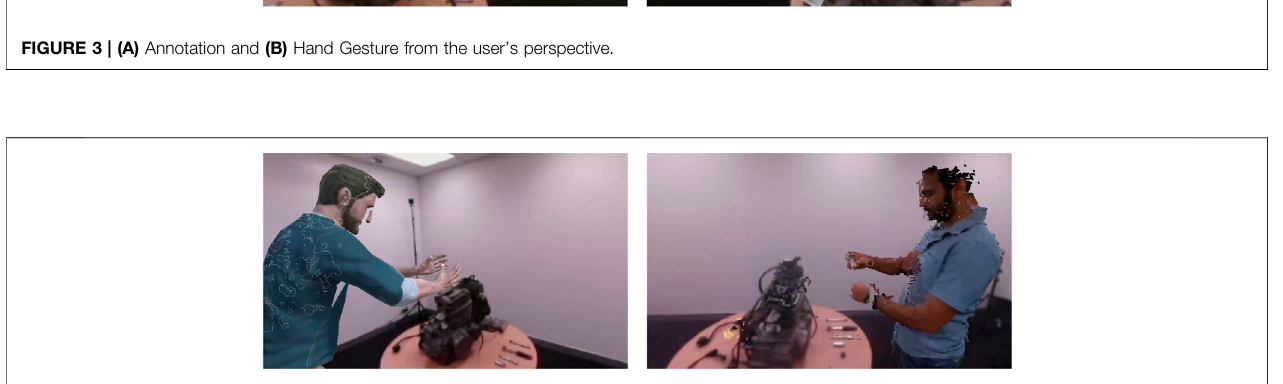
Frontiers in Virtual Reality |